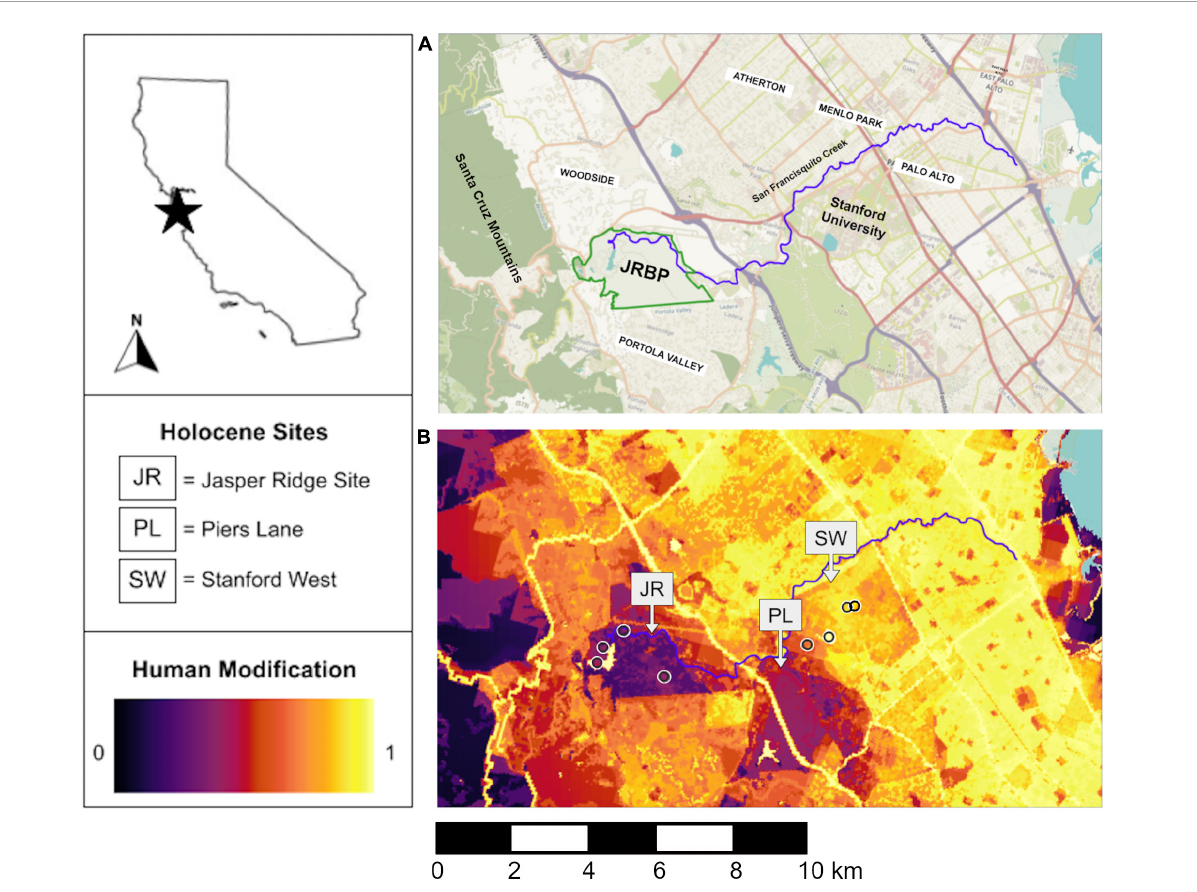
FIGURE1 (A) Street view (JRBP, Jasper Ridge Biological Preserve) and (B) human modification maps of the study region. Anthropocene pellet collection sites are represented as open circles in (B) . The human modification map is on a scale from 0 to 1, where 0 is pristine wilderness and 1 is completely transformed landscapes (Theobald,